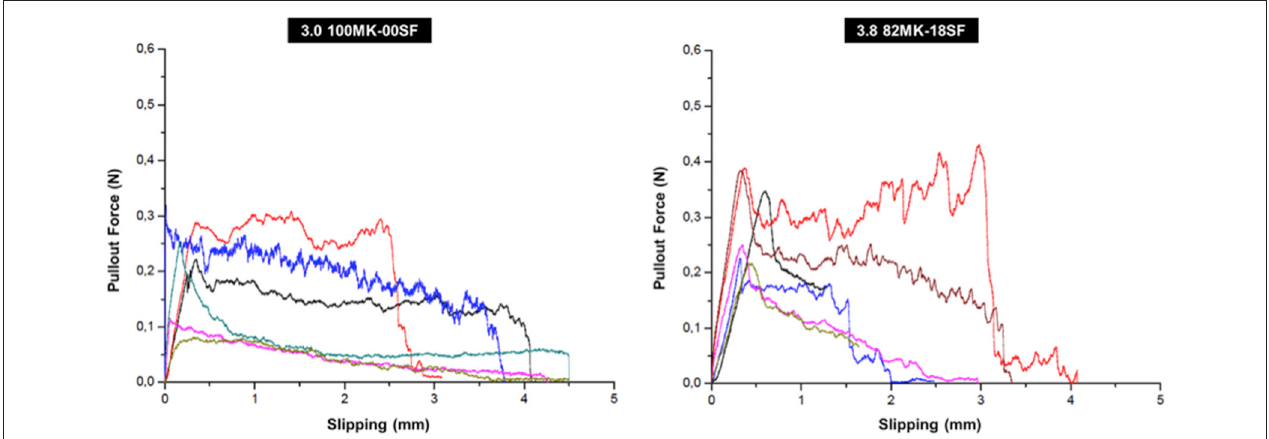
4mm) in two alkali-activated matrices with different SiO 2 /Al 2 O 3 ratios. =